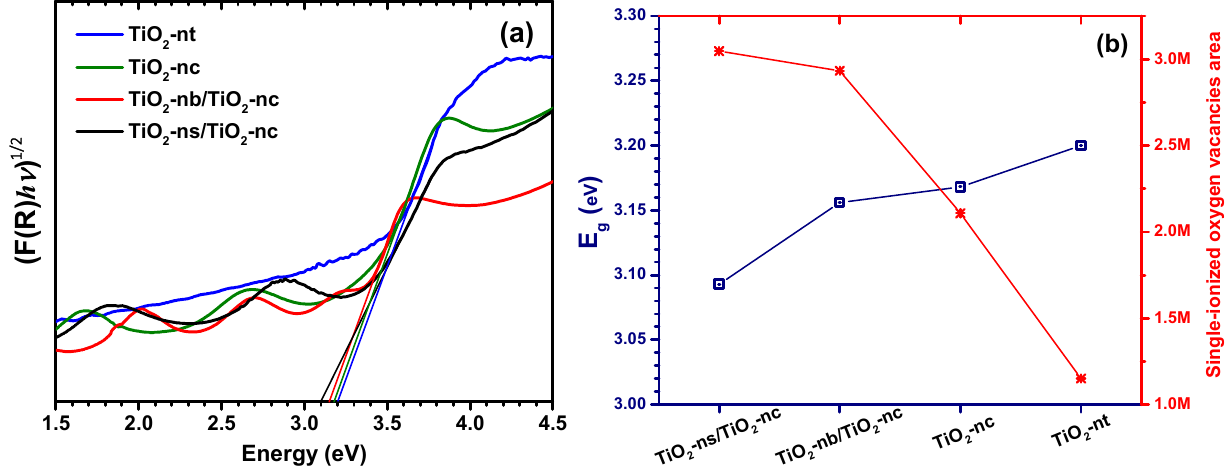
Figure 5. ( a ) The band gap energy of TiO 2 -nt, TiO 2 -nc, TiO 2 -nb/TiO 2 -nc and TiO 2 -ns/TiO 2 -nc obtained by Kubelka-Munk function. ( b ) Band gap energy and oxygen vacancies area for each film.